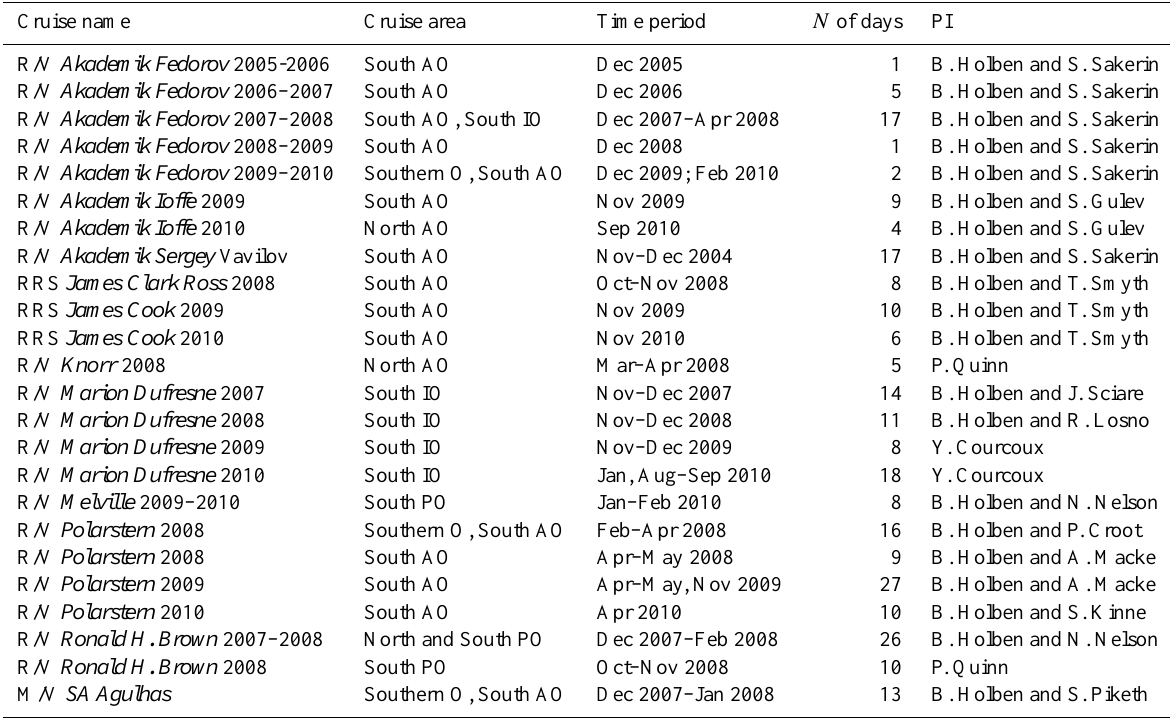
Table 1. List of cruises, cruise areas, and number of measurement days used in our analysis.